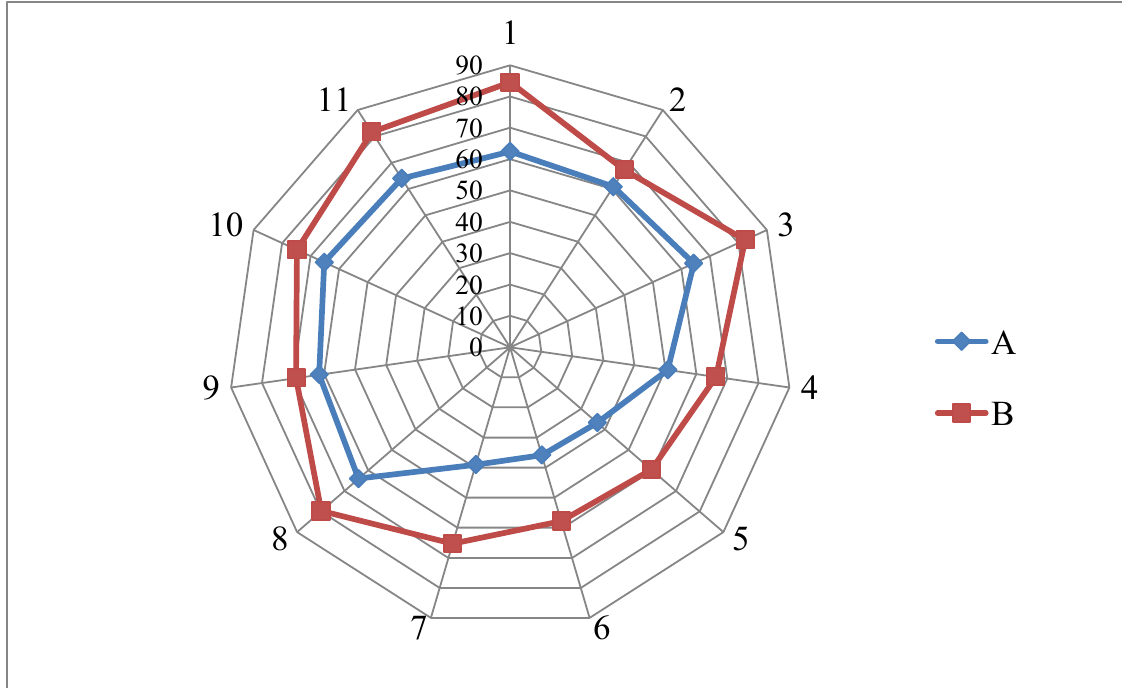
Fig.1. Formation model of acme-competence personality’s component in physical education specialists: 1 – attitude to own “Self” (“Self”-conception); 2 – sense of civil duty; 3 – ability to be psychologically close to other persons;; 4 – organization abilities; 5 – communicative abilities; 6 – creative potential (creativity); 7 – demand in achievement; 8 – emotional information level; 9 – control of emotions; 10 – empathy; 11 – recognition of other people emotions;; А – control group; В - experimental